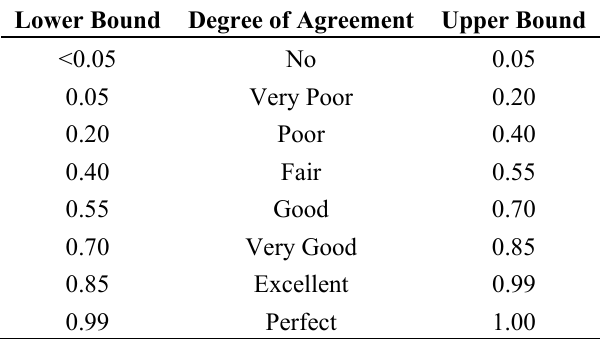
Table 3. Threshold values used for separating the different degrees of agreement for the Kappa statistic. From [21], used with